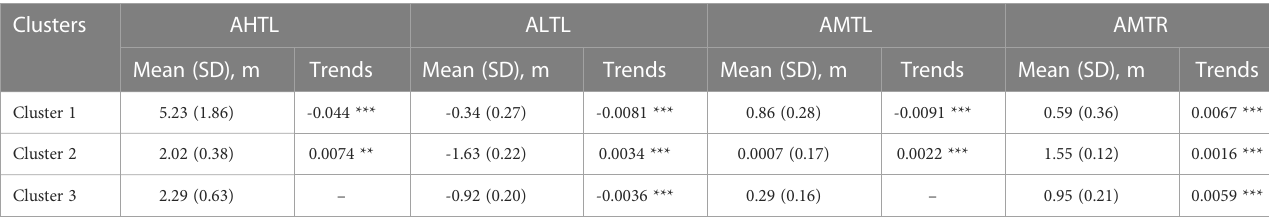
TABLE 4 Mean, Standard Deviations (SDs), and the temporal trends of four tidal variables in different clusters. Clusters